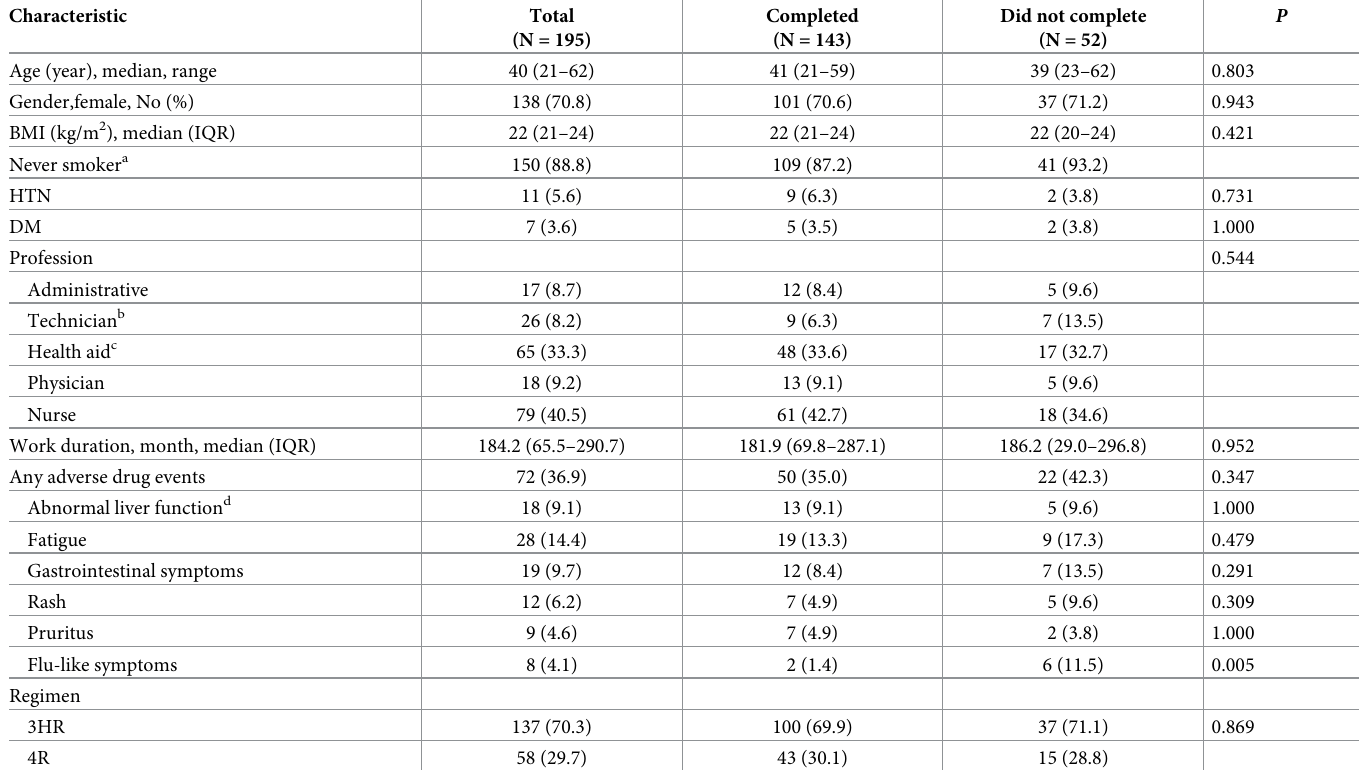
Table 3. Comparison of the characteristics between HCWs who completed LTBI treatment vs. those who did not. Characteristic Age (year), median, range